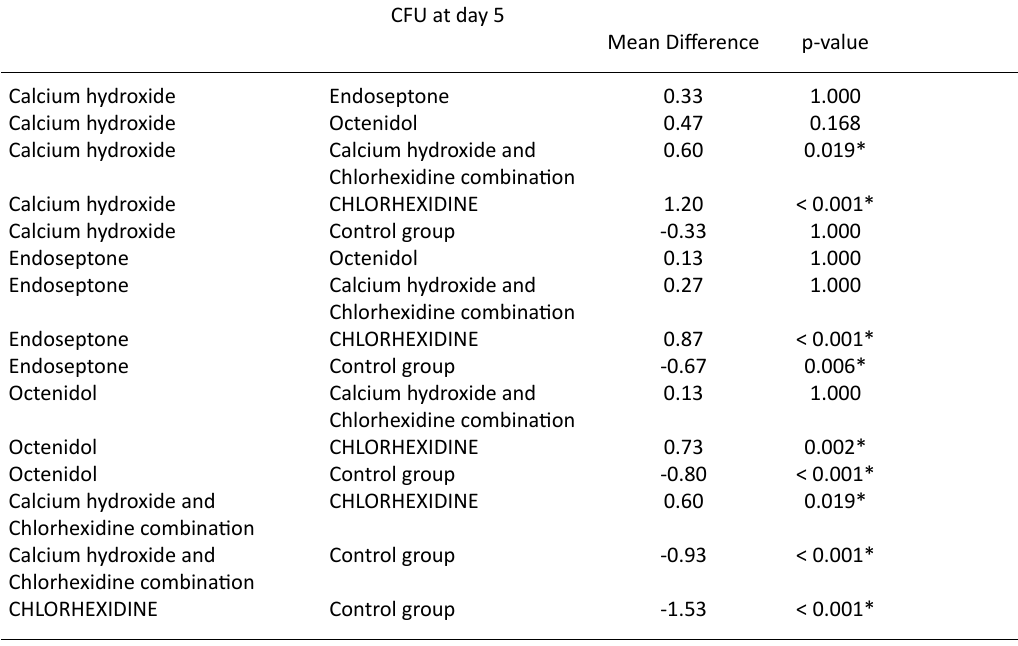
CFU at day 5 Mean Difference